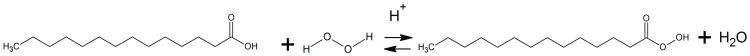
Synthesis of peroxytetradecanoic acid.The peroxytetradecanoic acid is formed in the reaction of tetradecanoic acid with hydrogen peroxide.